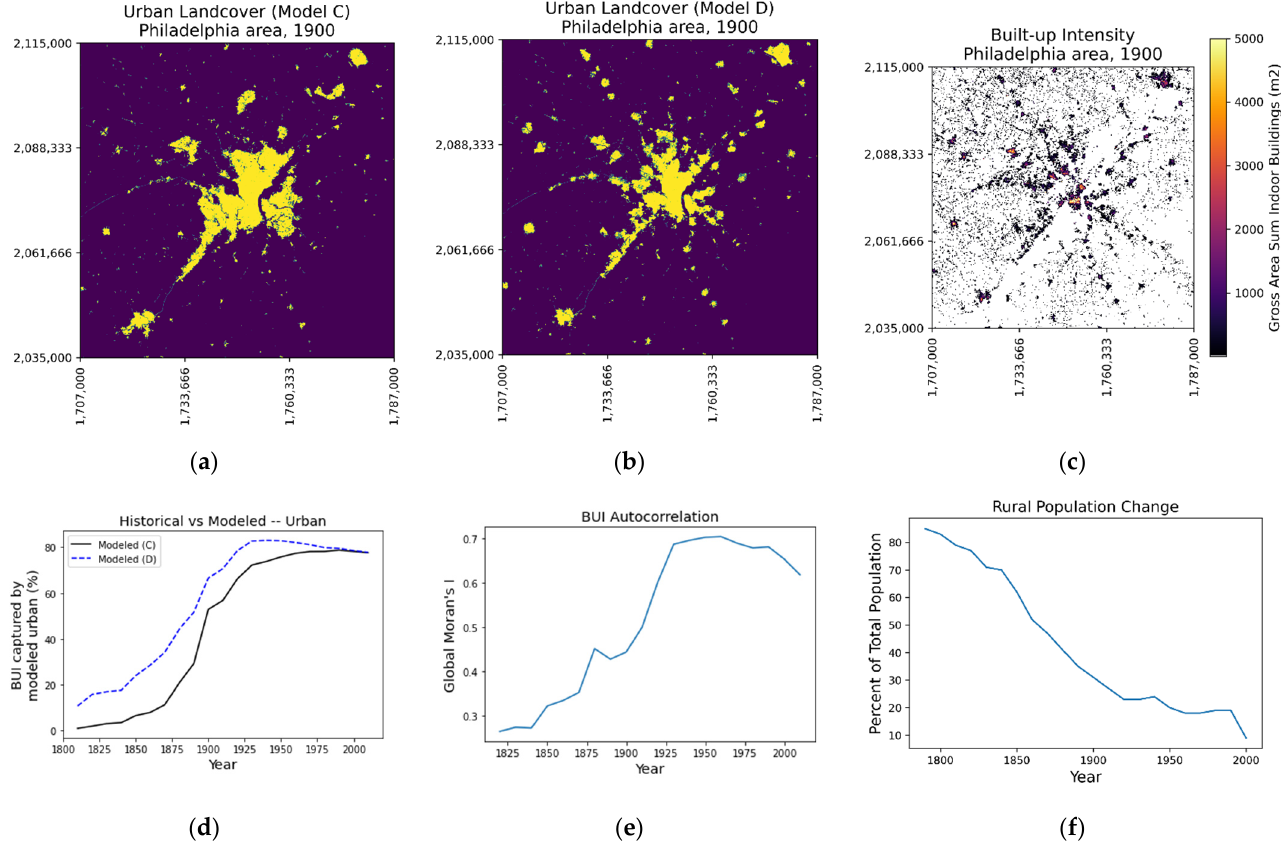
Figure 10. Urban land cover footprint modeled for Philadelphia area for the year 1900 ( a ) without incorporation of BUI and ( b ) with incorporation of BUI; ( c ) reference BUI for Philadelphia area, year 1900; ( d ) time series for model run (C), which did not use BUI in the urban module, and model run (D), which did use BUI in the urban module; ( e ) time series of BUI autocorrelation; ( f ) time series demonstrating rural population proportion change for the DRB.